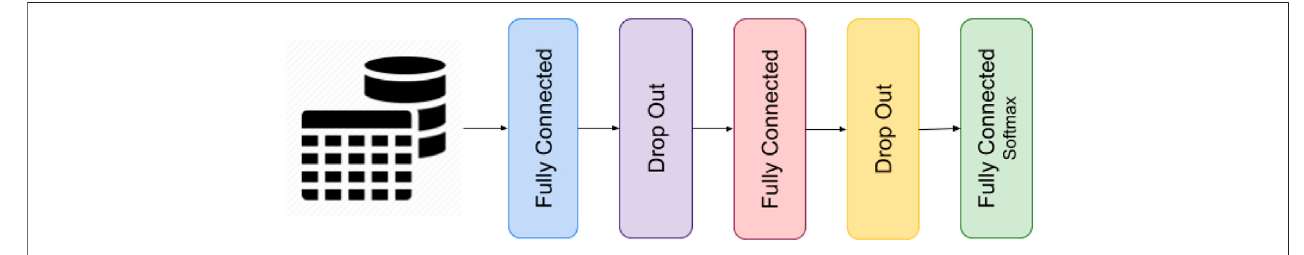
FIGURE 3 | Architecture of the feed-forward neural networks.